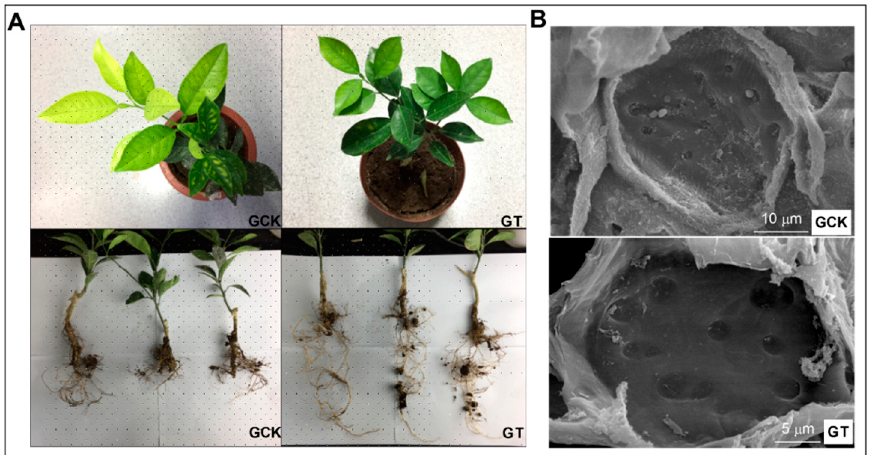
Int. J. Mol. Sci. 2020 , 21 , 3614